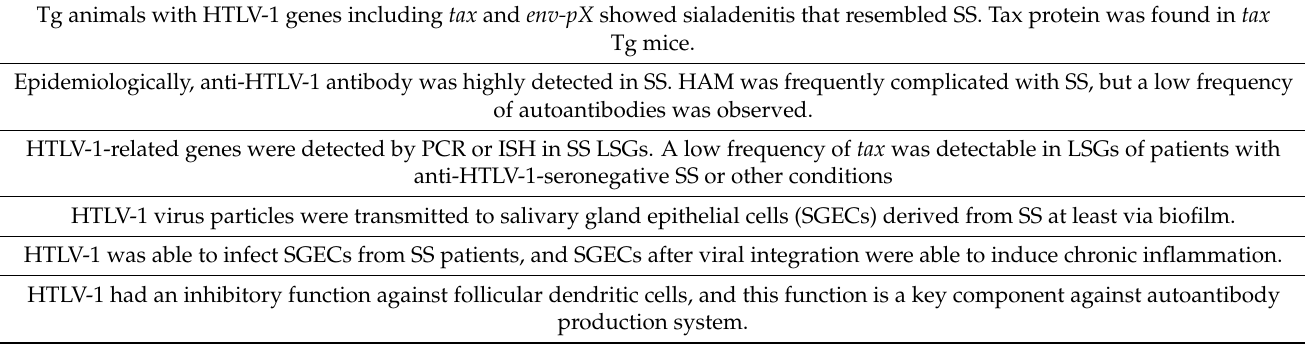
Table 2. Summary of findings suggesting an association between HTLV-1 and Sjögren’s syndrome. Tg animals with HTLV-1 genes including tax and env-pX showed sialadenitis that resembled SS. Tax protein was found in tax Tg mice. Epidemiologically, anti-HTLV-1 antibody was highly detected in SS. HAM was frequently complicated with SS, but a low frequency of autoantibodies was